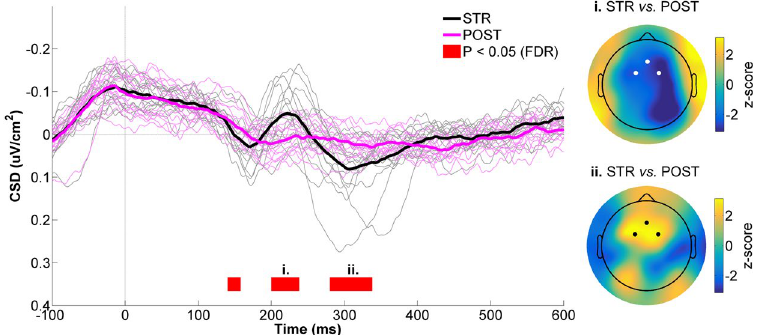
Figure 7. CSD activity recorded at the mid-frontal ROI for STR vs . POST. The black and magenta waveforms respectively represent CSD activity for STR and POST. The thin waveforms represent individual participant data, whereas the thick waveforms represent the mean CSD activity across participants. The red line highlights the time bins showing statistically significant differences between STR and POST ( p ≤ 0.05, FDR-corrected). Time “0 ms” corresponds to movement onset. The scalp maps represent the statistical z-scores across electrodes for CSD activity between STR and POST during two significant time windows (i. 200–240 ms; ii. 280–340 ms). The electrodes that make up the mid-frontal ROI (Fz, FC1 and FC2) are highlighted in both scalp